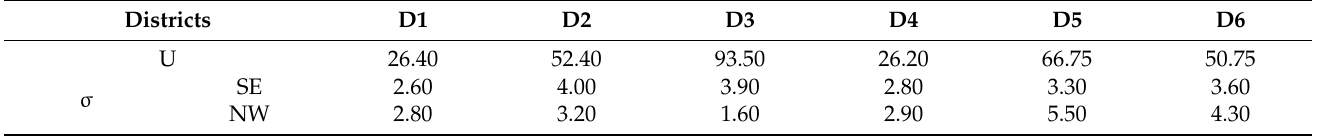
Table 16. The data of the wind speed dispersion and building